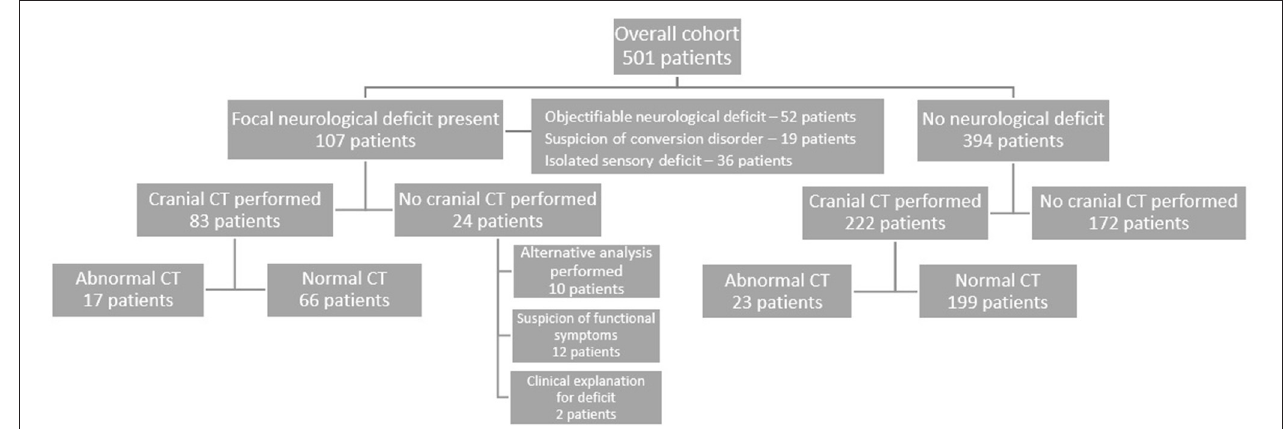
FIGURE 1 | Flowchart of performed cranial CT scans in patients with and without neurological deficit.